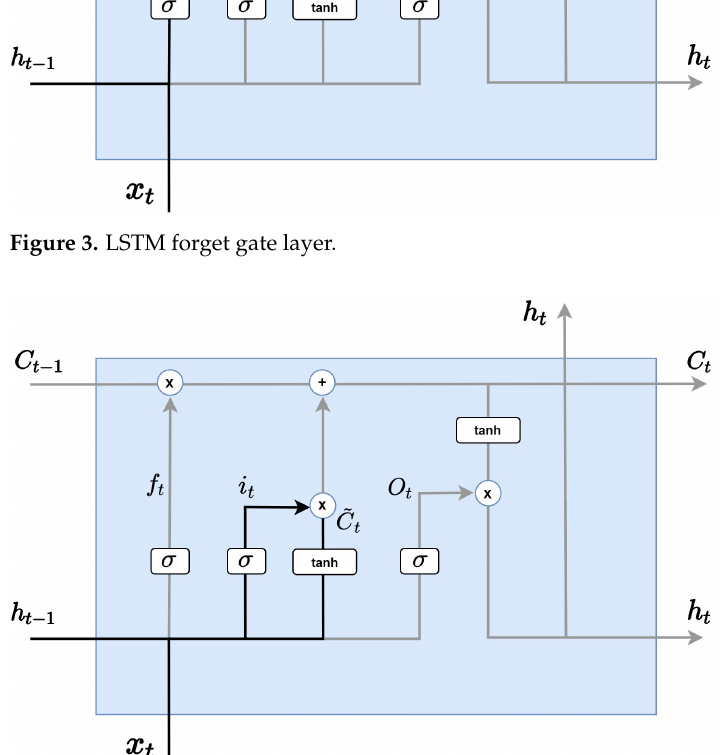
Figure 4. LSTM input gate